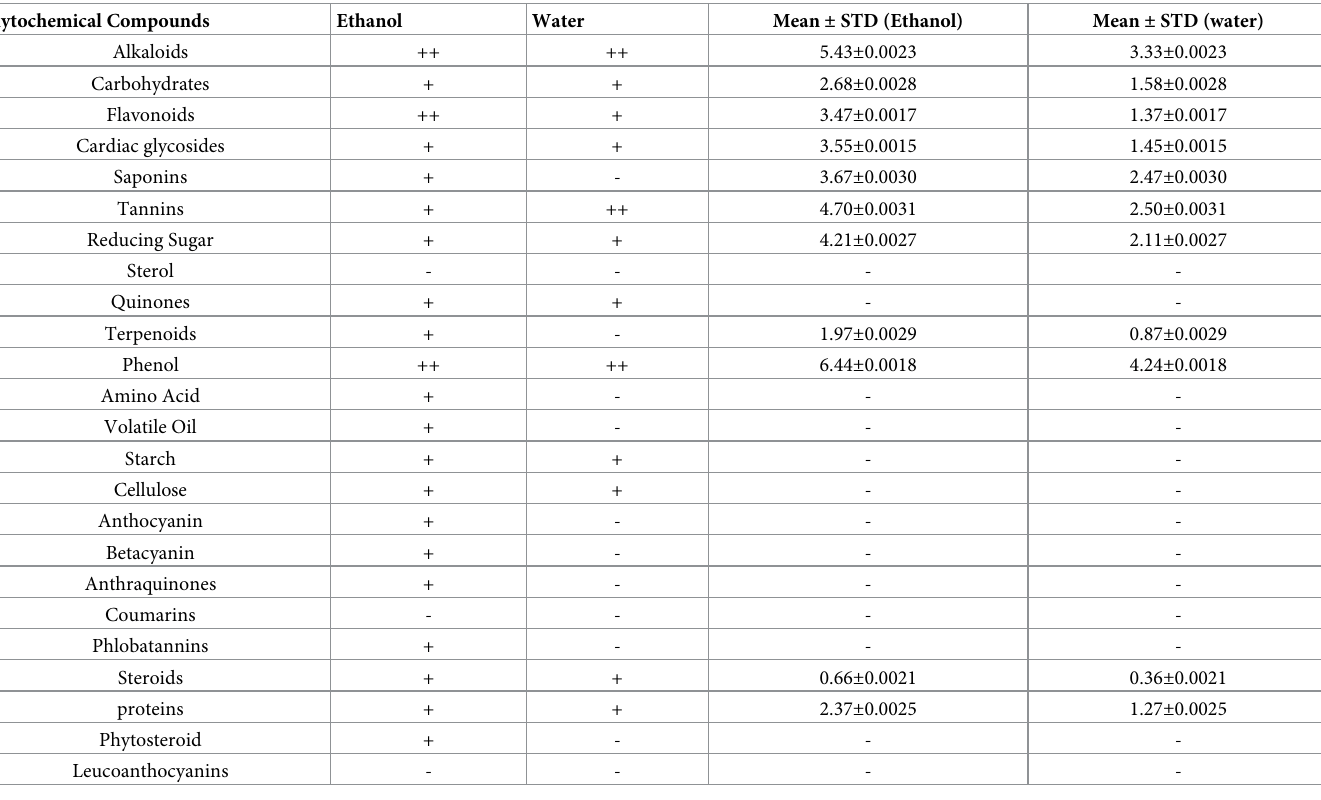
Table 4. Qualitative and quantitative phytochemical analysis of M . piperita in ethanolic and water extracts. Phytochemical Compounds Ethanol Water Mean ± STD (Ethanol) Mean ± STD (water) Alkaloids